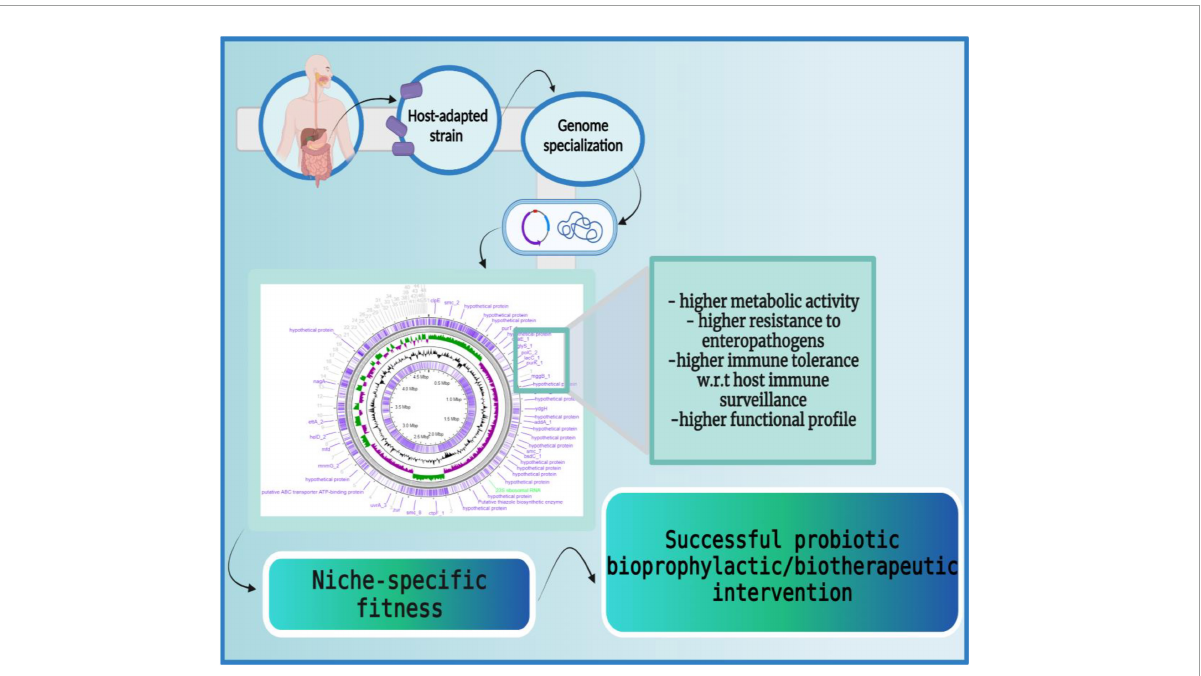
FIGURE5 Host-adapted strains harbor niche-specific phenotypic fitness. The host-adapted microbial strains carry niche-specific genetic signatures which enable them to adapt to the host ecosystems efficiently. These genetic modifications enable higher metabolic activity (larger carbohydrate utilization cassettes, production of β -galactosidases, etc.), higher resistance to enteropathogens (production of lactic acids, synthesis of secondary metabolites, etc.), higher immune tolerance (induction of anti-inflammatory cytokines like IL-10, IL-13, etc.), and higher functional profiles (production of bile salt hydrolases to endure bile salts, accumulation of ATP synthesizing cassettes for conditional respiration, etc.). Thus, host-adapted microbial strains possess a large repertoire of niche-specific genes that facilitate their persistence in the host. The figure was drawn with